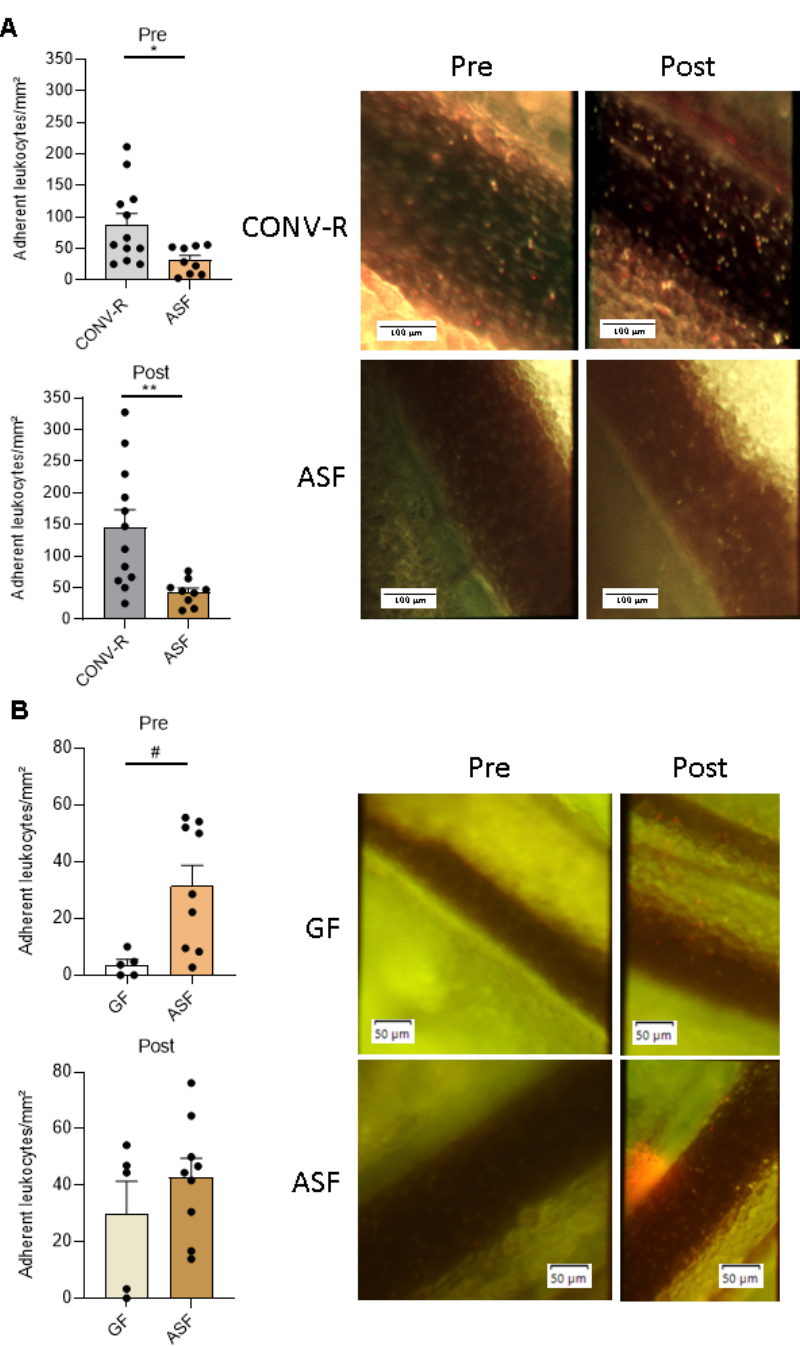
Figure 2. Leukocyte tethering to ischemia-reperfusion-injured mesenteric venules of gnotobiotic ASF-colonized mice. ( A ). Comparative in vivo analysis of adherent leukocytes in the mesenteric venules of CONV-R C57BL/6J (N = 12 mice per group) vs. ASF-colonized C57BL/6J mice (N = 9 mice per group), pre- and post-ischemia-reperfusion injury. Representative images are shown. Adhering leukocytes were stained with acridine orange (green). Scale bar: 100 µm. ( B ). Comparative in vivo analysis in the mesenteric venules of GF C57BL/6J (N = 5 mice per group) vs. ASF-colonized C57BL/6J mice (N = 9 mice per group), pre- and post-ischemia-reperfusion injury. Adhering leukocytes were stained with acridine orange (green). Scale bar: 50 µm. All data are expressed as means ± SEM. Statistical comparisons were performed using Student’s t -test (* p < 0.05, ** p < 0.01) or Mann–Whitney test (# p < 0.05).